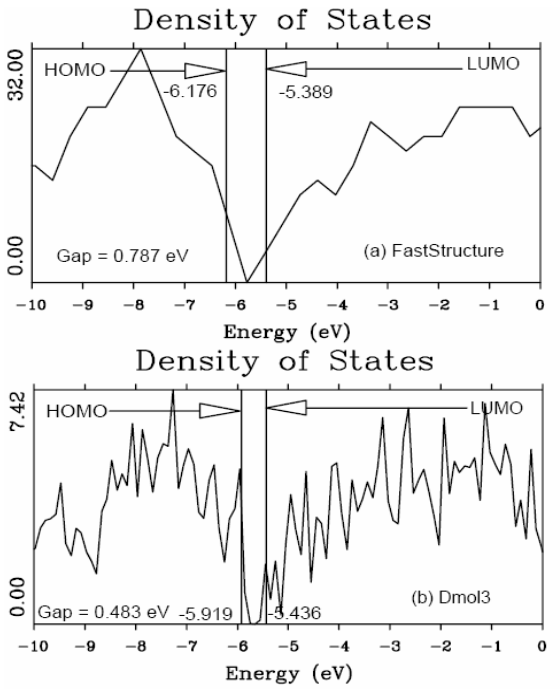
Figure 36. eDOS curves for the 10/2 fs cell of a- SiH calculated using F AST , curve ( a ), and DM OL 3, curve ( b ). HOMOs, LUMOs and gaps are